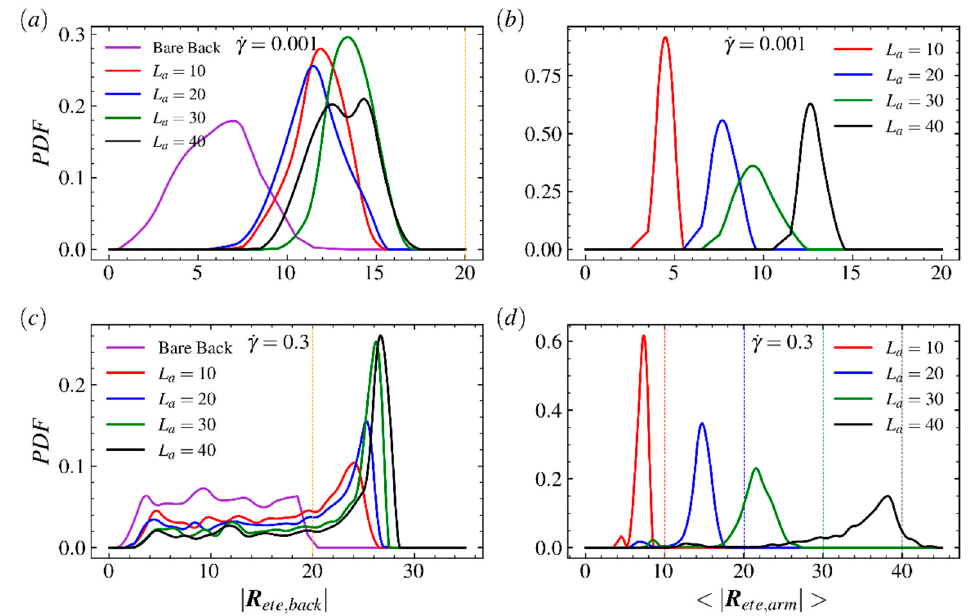
Figure 3. Probability distribution function (PDF) of the end-to-end distance of ( a , c ) the backbone and ( b , d ) arms of the LCB polymer in shear flow at shear rate 0.001 ( a , b ) and 0.3 ( b , d ). In ( a ) the bare backbone (purple) and comb polymers with arm length L a = 10 (red), 20 (blue), 30 (green) and 40 (black) are considered. The orange vertical lines in ( a , c ) are used to mark the backbone’s contour length L b = 20. The vertical lines in ( d ) are used to mark the arm’s contour length L a = 10 (red), 20 (blue), 30 (green) and 40 (black), respectively.